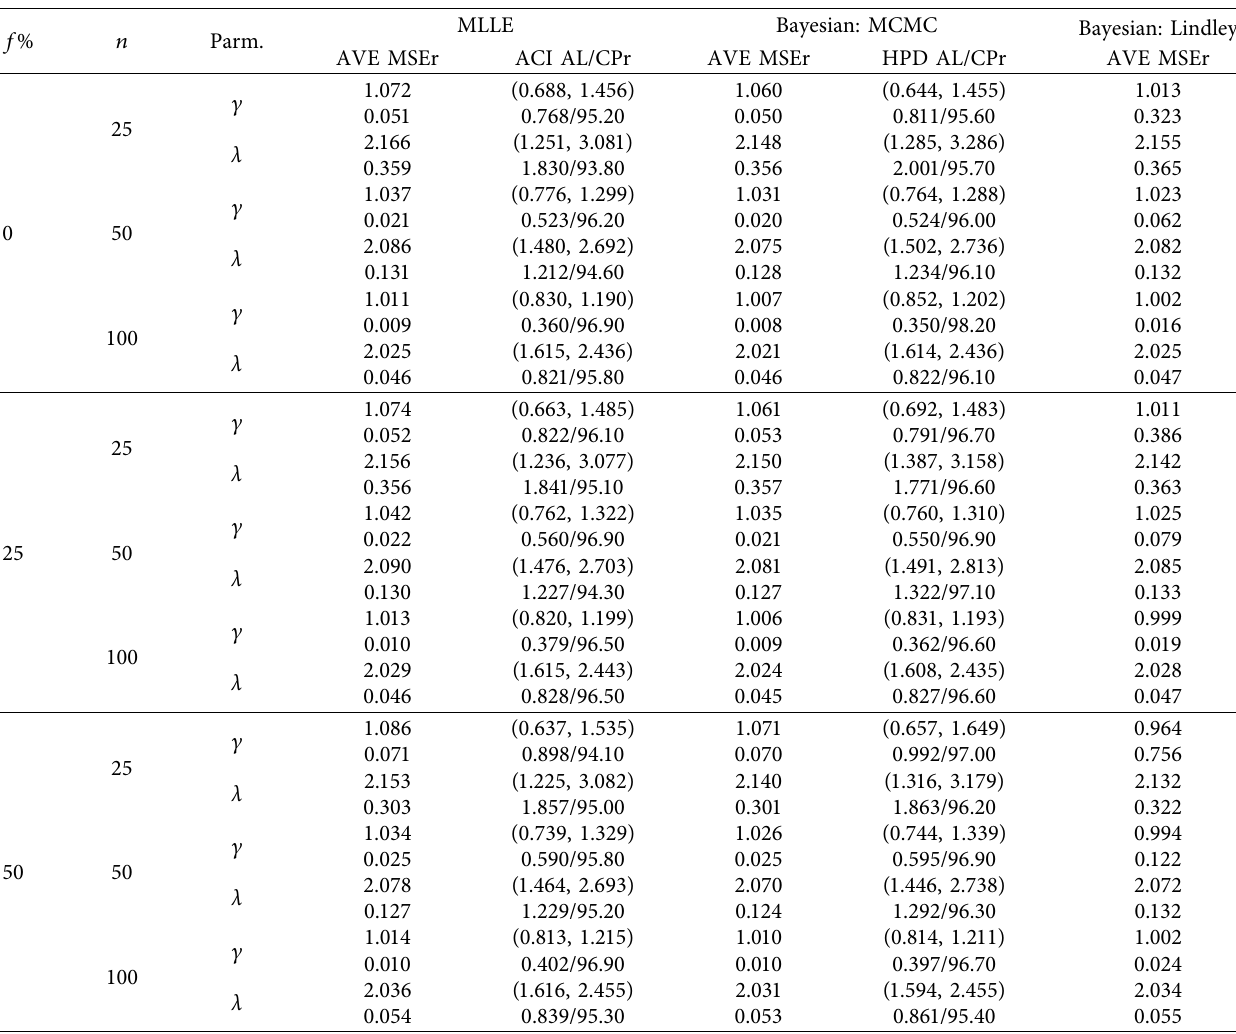
Table 4: Numerical results of AVEs, ACIs, MSErs, ALs, and CPrs (in %) for c � 1 and λ � 2 under number of stages m � 3. f %